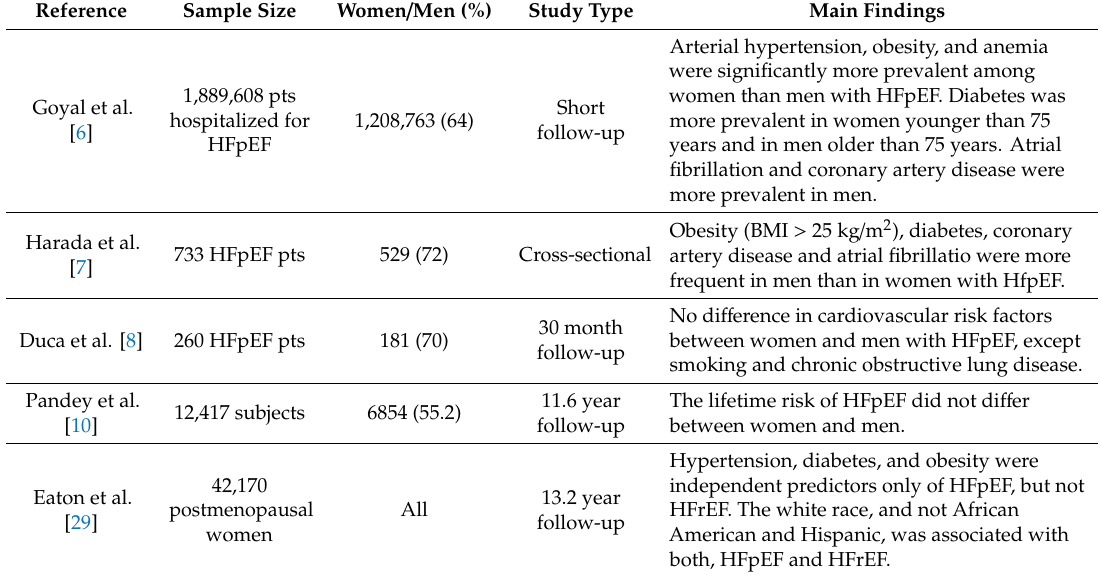
Table 1. Sex-specific di ff erences in risk factors in HFpEF